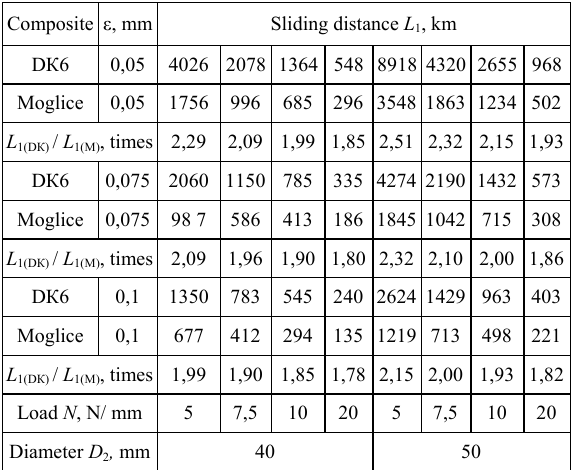
Table 3. The impact of the radial clearance on the relative reduction of L 1(D К ) / L 1( М ) Composite ε , mm Sliding distance L 1 ,